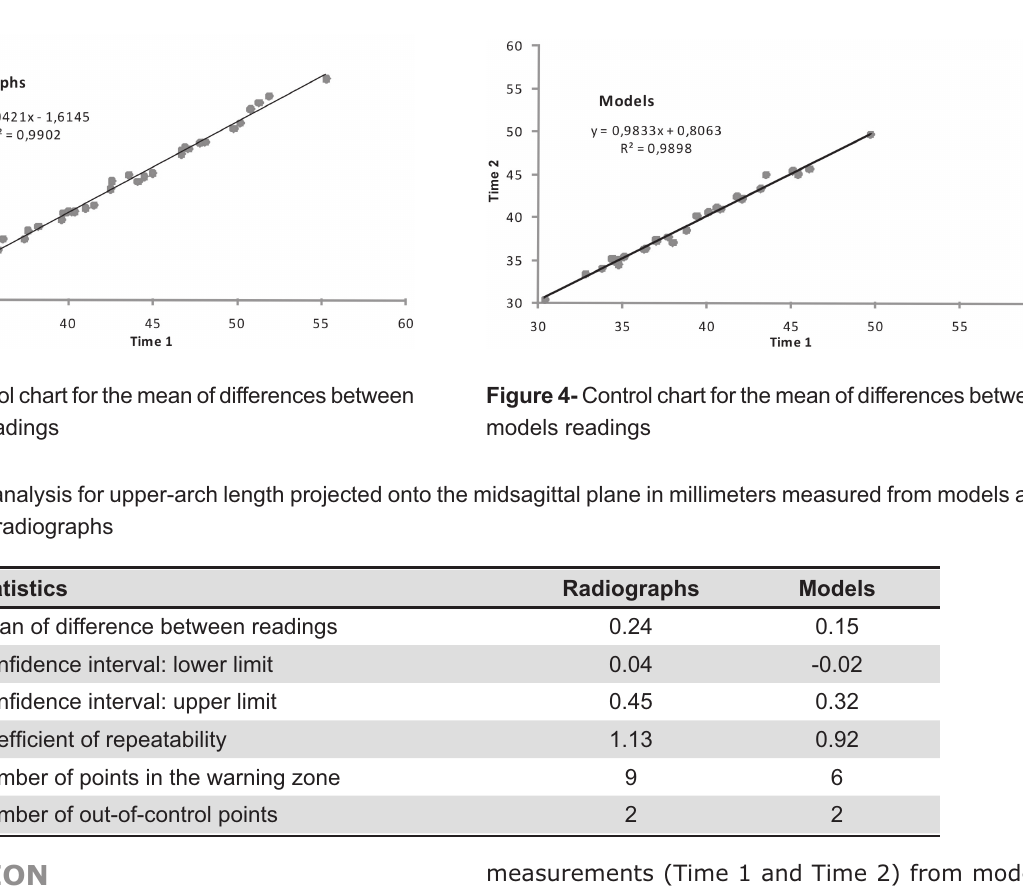
Figure 1- Double readings of radiographs with the line of equality